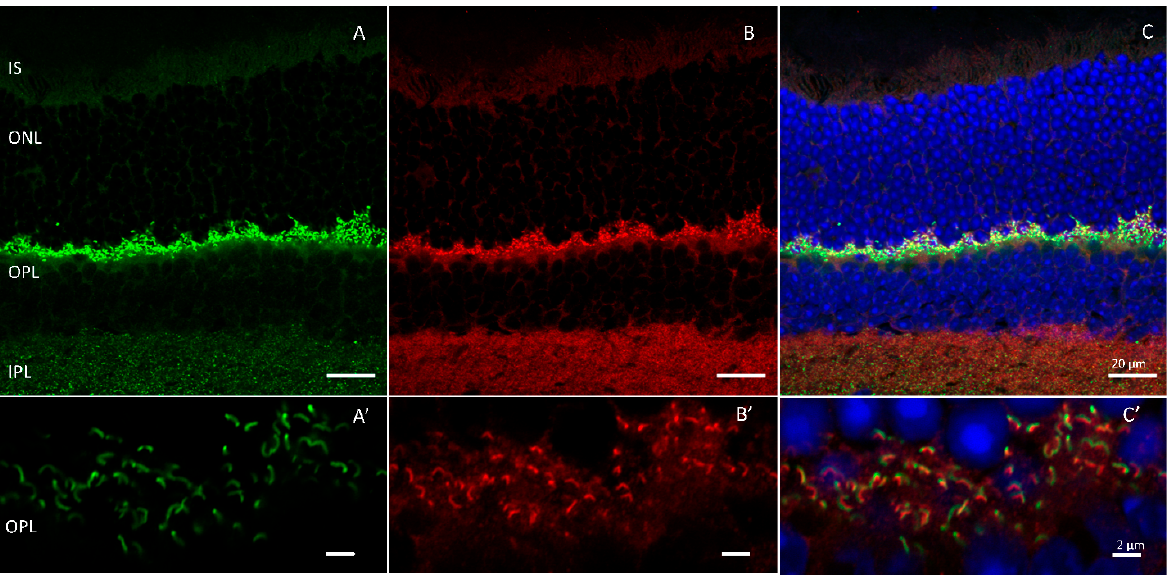
Figure 5. Rim2 is expressed at the ribbon synapses of the OPL and the IPL in the mouse retina. Shown is antibody staining of an adult wildtype mouse retina labeled with ( A ) Ribeye (green) and ( B ) Rim2 (red). ( C ) merged. Outer plexiform layer shown in ( A’ – C’ ). Scale bar = 20 µm in ( A – C ) and 2 µm in ( A’ – C’ ).